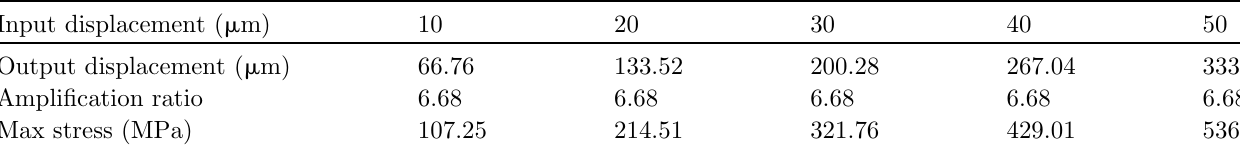
Table 2. Ampli fi cation and strength under different input displacement.